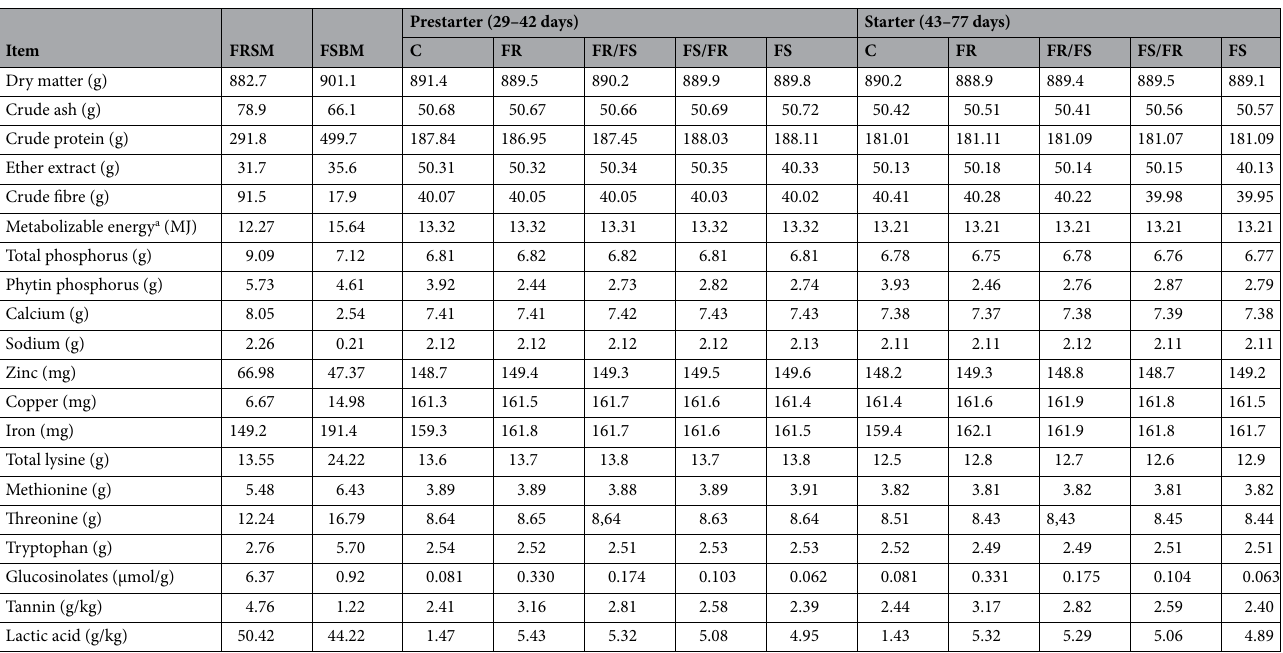
Table 1. Content of analysed nutrients and bioactive substances in 1 kg of FRSM (n = 4) and FSBM (n = 4) and piglet diets (n = 3) 10 . FSBM fermented dried soybean meal, FRSM fermented dried rapeseed meal. Metabolizable energy a was calculated according to the equation proposed by Kirchgessner and Roth 11 . a Feeding groups: C—control; FR- group receiving a diet with 8% FRSM; FR/FS—group receiving a diet with 6% FRSM and 2% FSBM; FS/FR—group receiving a diet with 6% FSBM and 2% FRSM; FS—group receiving a diet with 8%